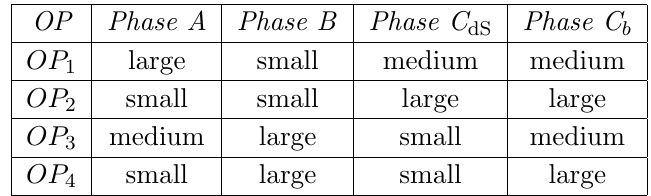
Figure 5 . Behaviour of the order parameters OP 1 , . . . , OP 4 , de(cid:12)ned in eqs. (4.1){(4.4), in CDT with spherical spatial topology ((cid:6) = S 3 ). The left plot shows the OPs as a function of (cid:1) for (cid:12)xed (cid:20) 0 = 2 : 2, which corresponds to a vertical line in the phase diagram in (cid:12)gure 3 starting in phase B ((cid:1) < 0 : 05), going through phase C b (0 : 05 < (cid:1) < 0 : 35), to phase C dS ((cid:1) > 0 : 35). The right plot shows the OPs as a function of (cid:20) 0 for (cid:12)xed (cid:1) = 0 : 6, which corresponds to a horizontal line in the phase diagram in (cid:12)gure 3 starting in phase C b ( (cid:20) 0 < (cid:24) 1 : 0), going through phase C dS ( (cid:24) 1 : 0 < (cid:20) 0 < 4 : 7), to phase A ( (cid:20) 0 > 4 : 7). The OP 1 , OP 2 and OP 4 were rescaled to (cid:12)t into a single plot, and due to a very large range of OP 3 (a few orders of magnitude) we plot the rescaled ln OP 3 instead of OP 3 , the rescaling in the left plot being identical to that in the right plot.